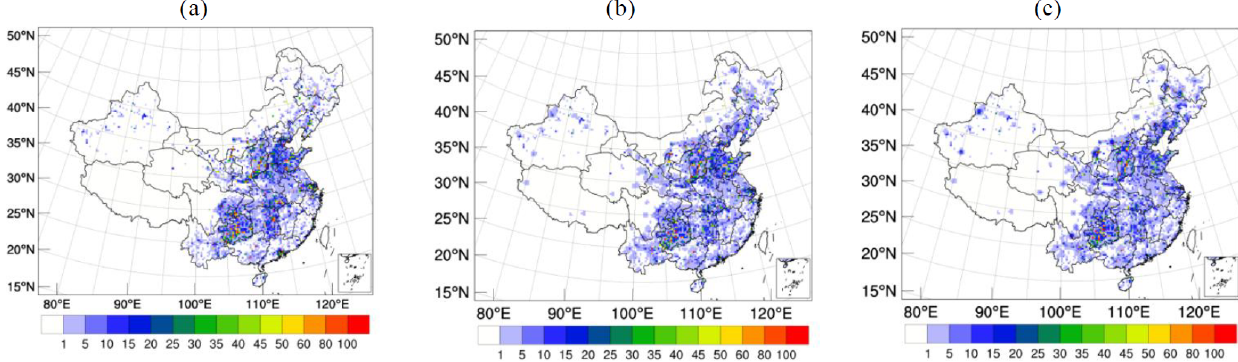
Figure 6. Emissions in China for (a) MEIC_2016, (b) 2019, and (c) 2020. Units: molkm − 2 h − 1 . Insets: South China Sea.